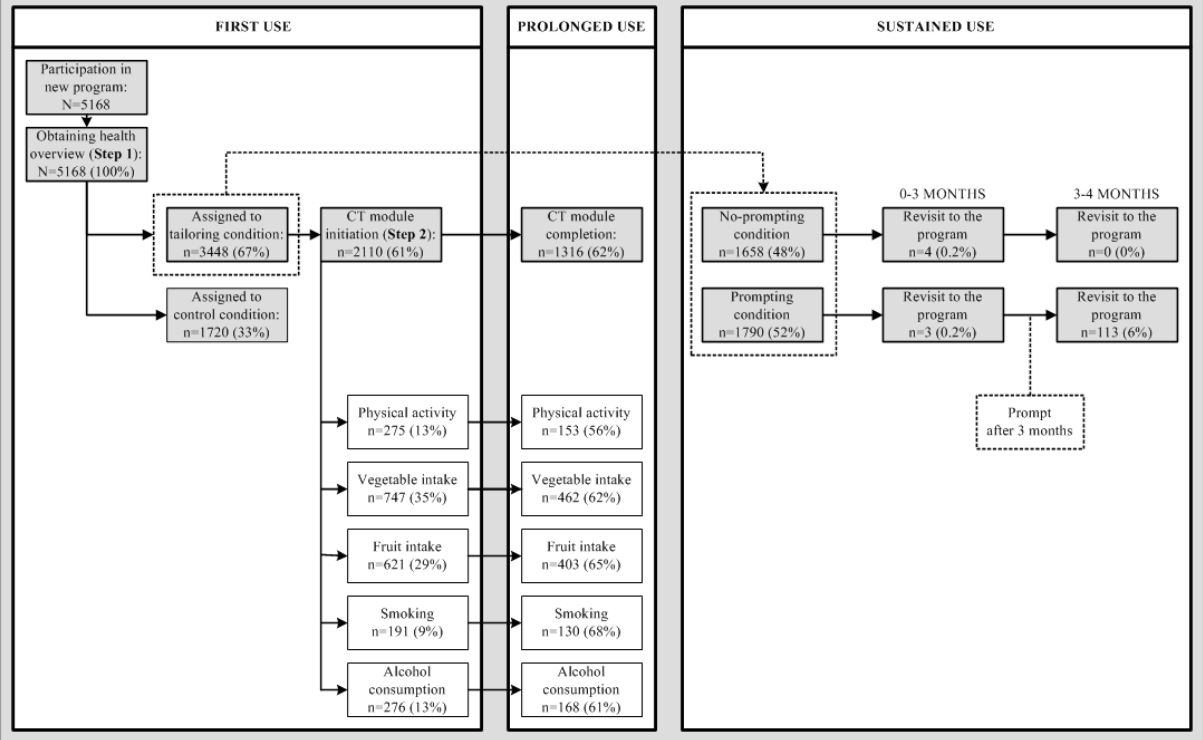
Figure 1. Flowchart exposure to CT program: first use, prolonged use and sustained